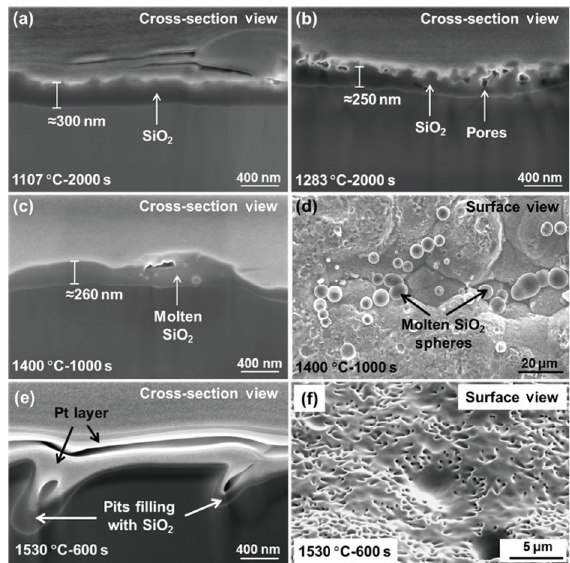
Fig. 5 Microstructures of SiO 2 layers formed at ~3 kPa: (a) ~1107 ℃ for 2000 s, (b) ~1283 ℃ for 2000 s, (c, d) ~1400 ℃ for 1000 s, and (e, f) ~1530 ℃ for 600 s.